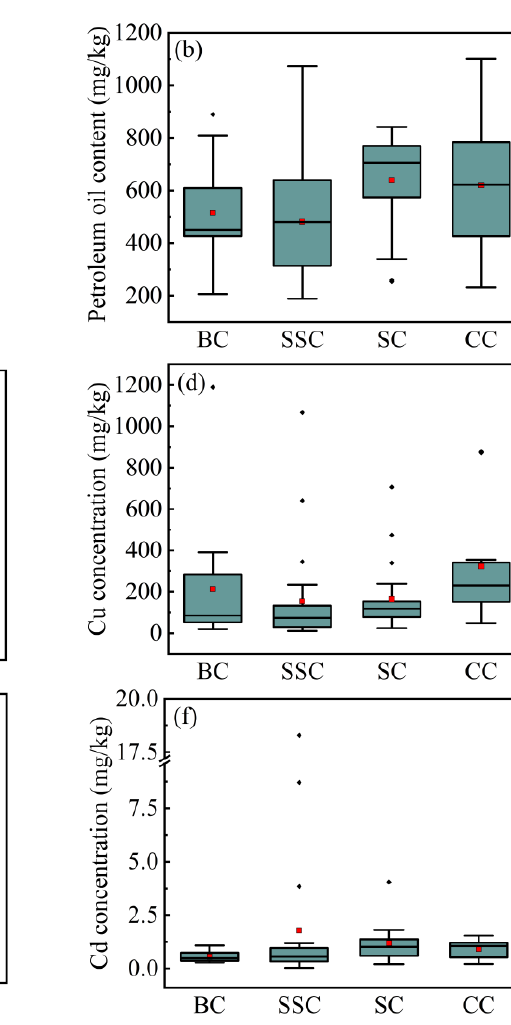
Figure 8. Box-plot of ( a ) TP, ( b ) PO, ( c ) OM, ( d ) Cu, ( e ) Ni, and ( f ) Cd level in different conduits. *: multiplication sign.